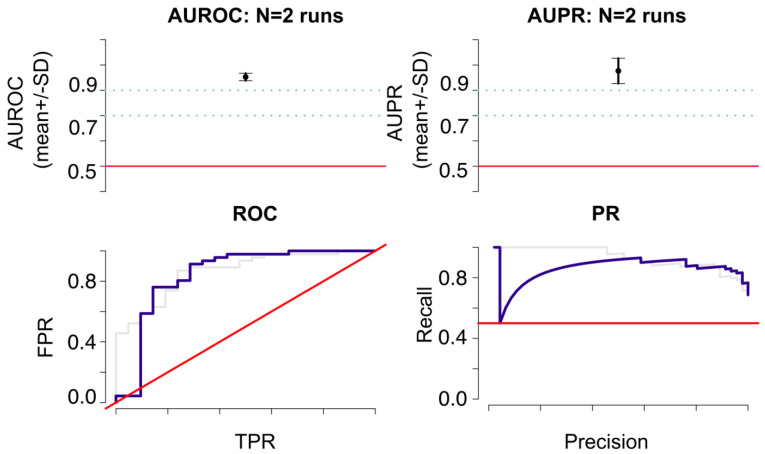
Average model performance for binary classification of breast tumour as "LumA" or "other" using clinical and transcriptomic data.Clockwise from top-left: Mean area under ROC curve across train/test splits; mean area under precision-recall curve; precision-recall curve (average in blue; individual splits in grey); ROC curves (average in blue; individual splits in grey).